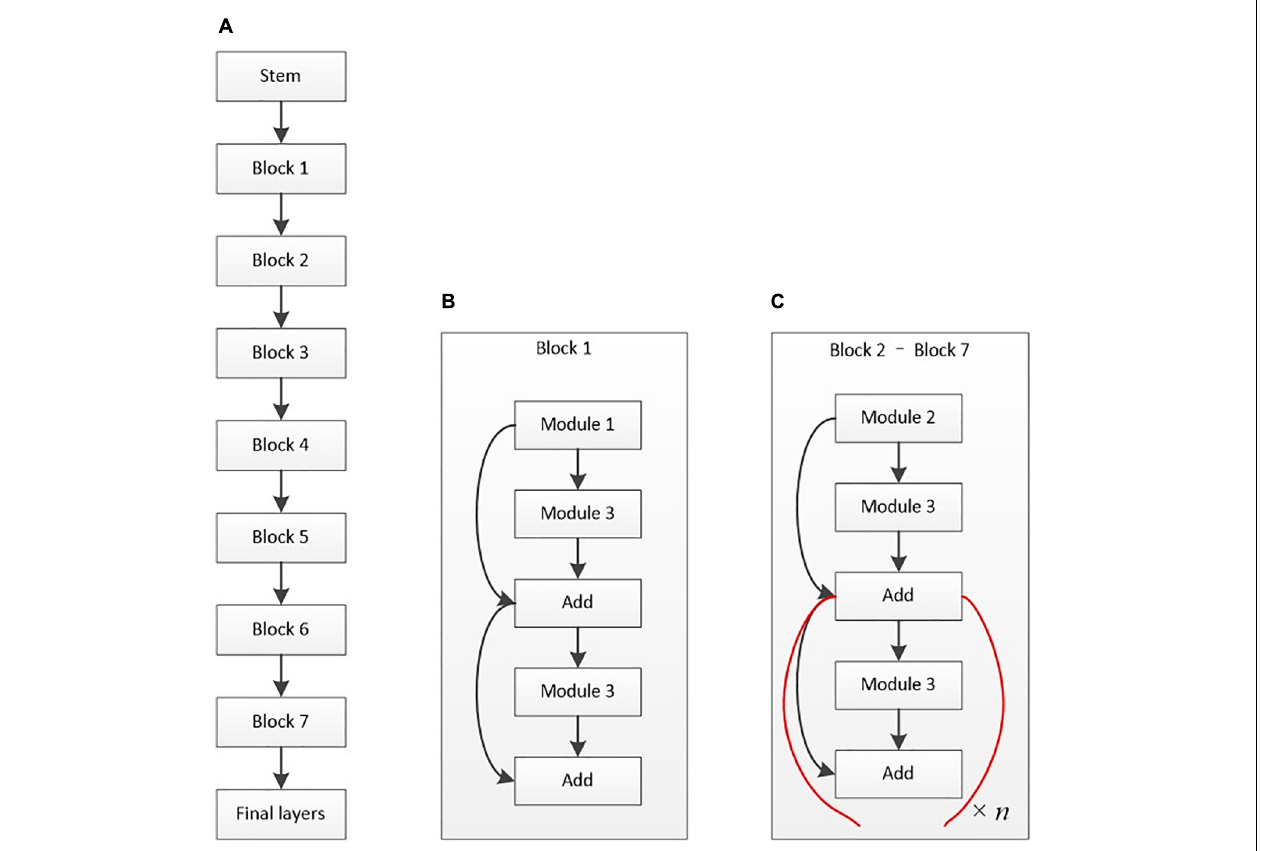
FIGURE 4 | Architectural diagram of EfficientNet-B6. (A) Basic architecture. (B) Structure of block 1. (C) Structure of blocks 2–7. The basic structure of the stem is composed of a data input layer, convolution layer, activation function layer, and other layers. Module 1 mainly contains depth-wise convolution (D-Conv2D), batch normalization, and activation. Module 2 is primarily the connected two modules 1 with zero padding. Module 3 mainly contains global average pooling (GAP), rescaling, and Conv2D. The final layers include Conv2D,batch normalization, and activation